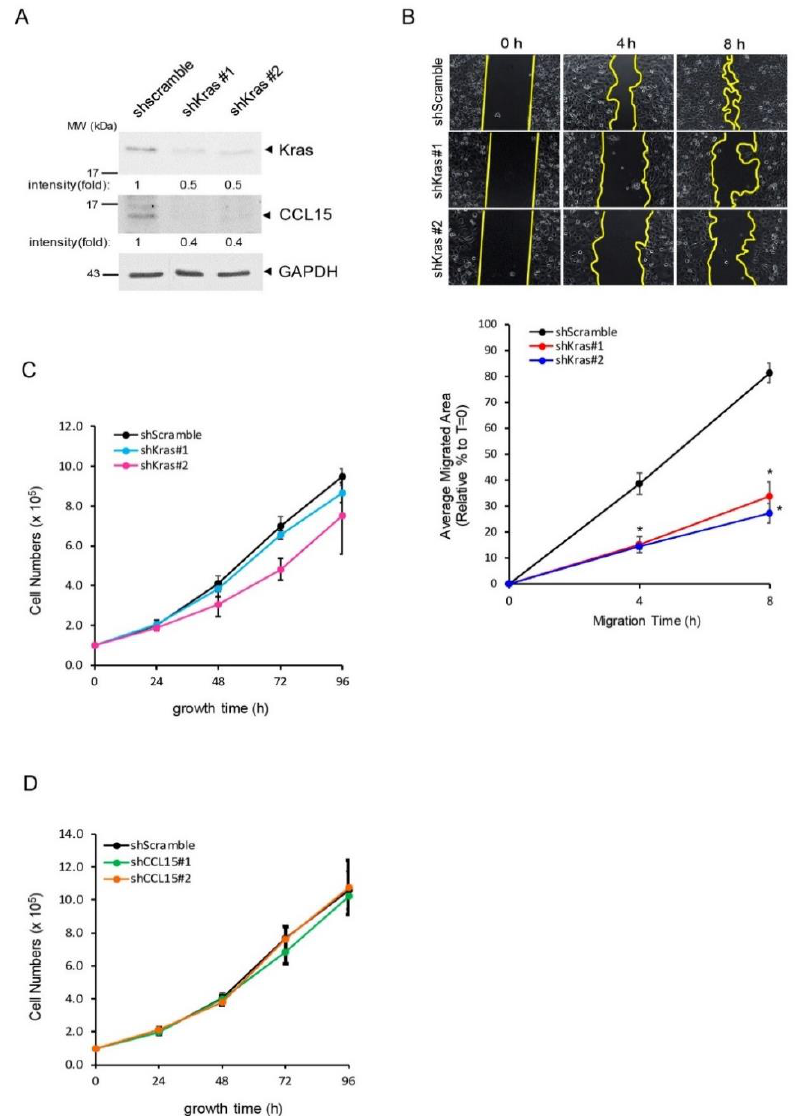
Figure 5. Oncogenic Kras-mediated CCL15 modulated cell migration of PDAC rather than PDAC cell growth. ( A ) Panc-1 cells stably expressing shScramble, shKras #1, or shKras #2 were examined for the expression levels of Kras and CCL15 using immunoblots. The expression of GAPDH was used as a loading control. Quantification result from 3 independent experiments is shown in Figure S7. ( B ) Panc-1 cells stably expressing shScramble, shKras #1, or shKras #2 were evaluated for their cell migration ability at the indicated time points. *: p < 0.05 as compared to shScramble at the same migration time point. ( C ) Panc-1 cells stably expressing shScramble, shKras #1, or shKras #2 were assessed for their cell growth over a 96 h time period. ( D ) Similar to ( C ), Panc-1 cells stably expressing shScramble, shCCL15 #1, or shCCL15 #2 were subjected to a cell proliferation assay. The cell numbers were counted over a 96 h time period. Original blots see supplementary File S1.